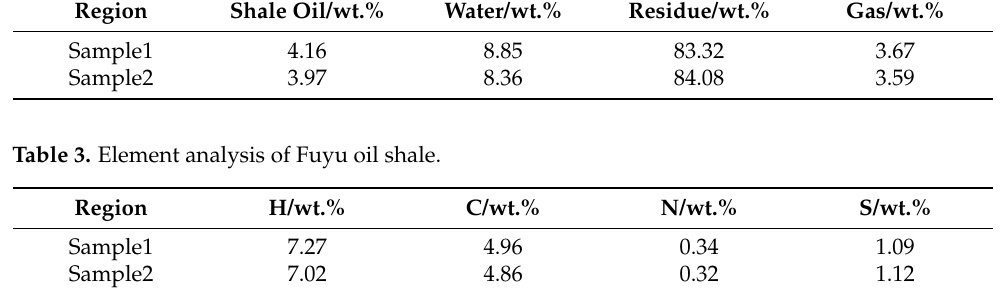
Table 2. Fisher analysis of Fuyu oil shale.